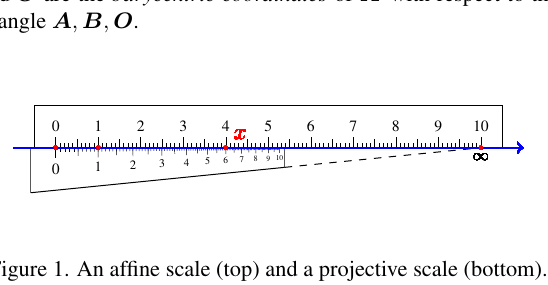
Figure 1. An affine scale (top) and a projective scale (bottom). Both scales agree at 0 and 1. The bottom ruler would already show infinity where the top rule is just at 10. In this case the bottom ruler shows 9 x when the top ruler shows x , e.g. the 10 − x bottom ruler shows 6 = 9 · 4 when the top ruler shows x = 4 . Figure 2. Affine grid. Vector x can be written as linear 10 − 4 combination x = 0 . 7 · a + 2 . 6 · b of the vectors a and b . Moreover, (0 . 7 , 2 . 6 , 1 − 0 . 7 − 2 . 6) t are the barycentric coordinates of X with respect to the triangle A , B , O